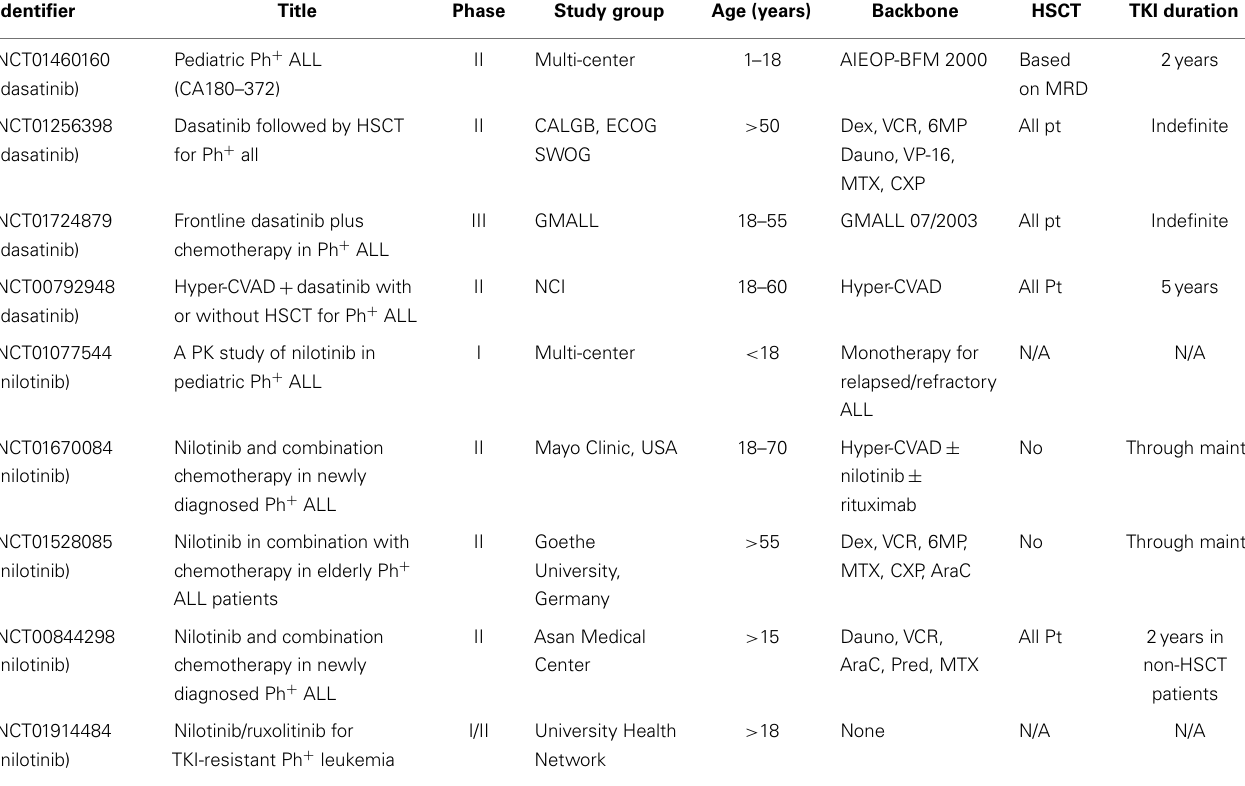
Table 3 | Selected open clinical trials (clinicaltrials.gov) investigating dasatinib and nilotinib for Ph + ALL